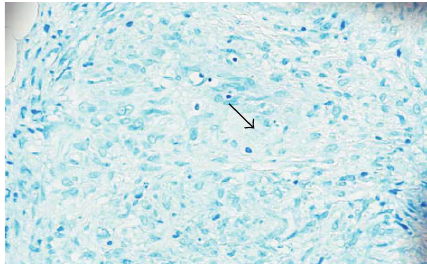
Figure 3: AFB staining of round ligament revealing single acid-fast bacillus consistent with mycobacterium.